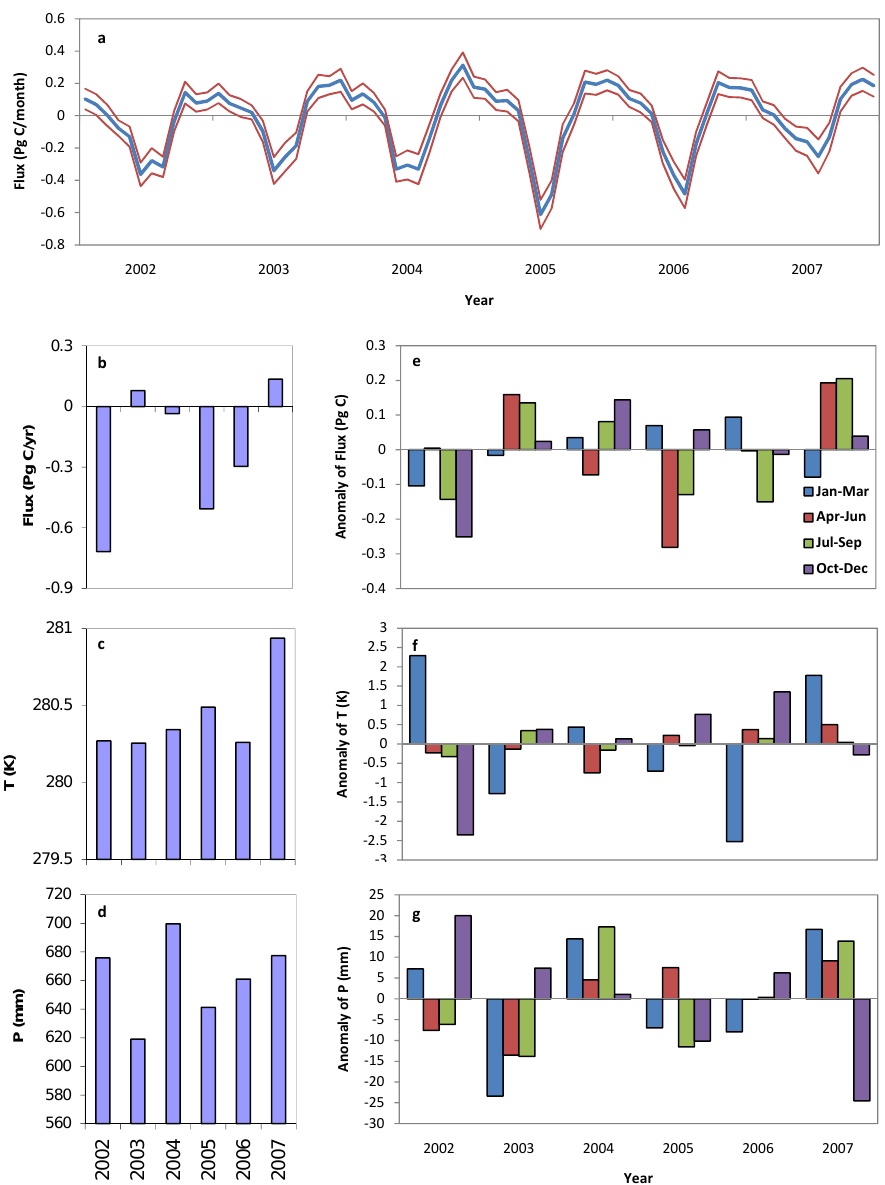
Fig. 9. The variations of inverted fluxes and climatic conditions from 2002 to 2007 in Europe region (Region 39). (a) The inverted monthly fluxes (thick blue line) and their uncertainties (thin red line), (b) The inverted annual fluxes, (c) the annual mean temperatures, (d) the annual precipitations, (e) the 3-monthly anomalies of inverted fluxes, (f) the 3-monthly temperature anomalies, and (g) the 3-monthly precipitation